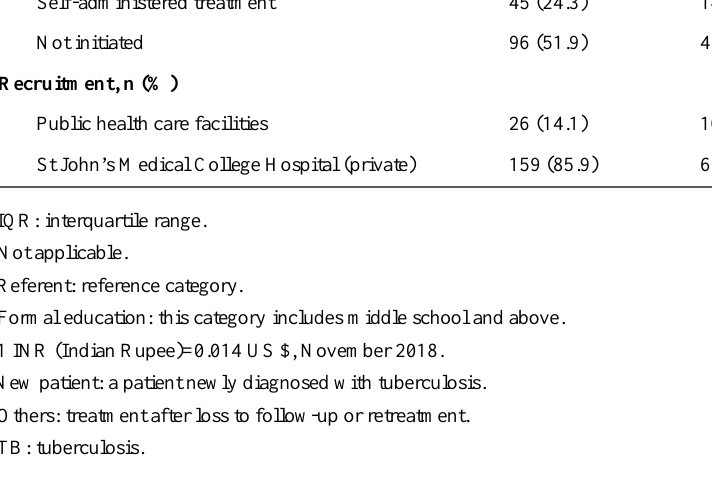
Table 2. Access to mobile phones and its association with demographic characteristics